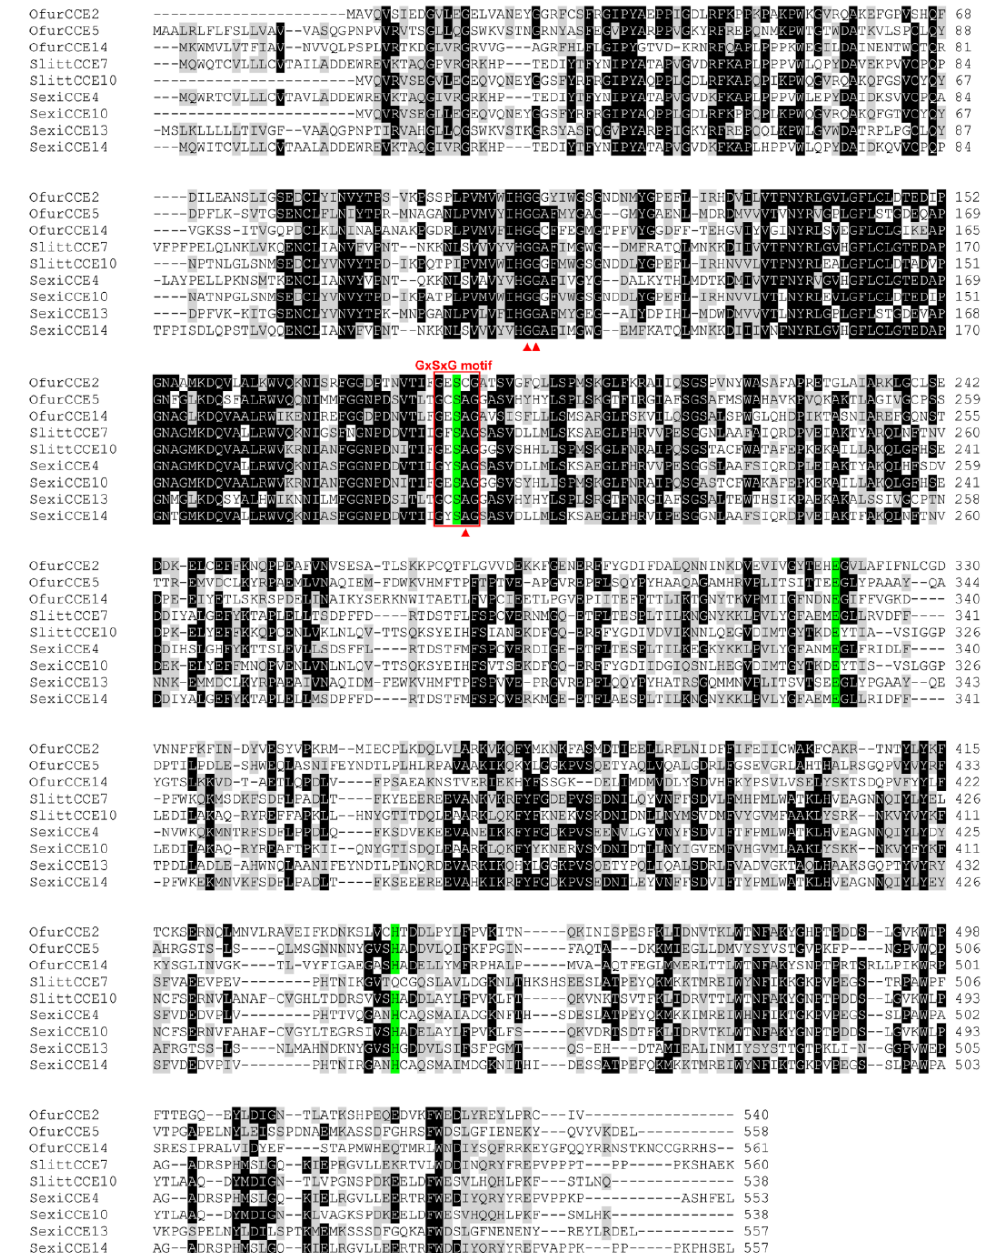
Figure 1. Multiple sequence alignment of the representative CCEs from Ostrinia furnacalis (Ofur-